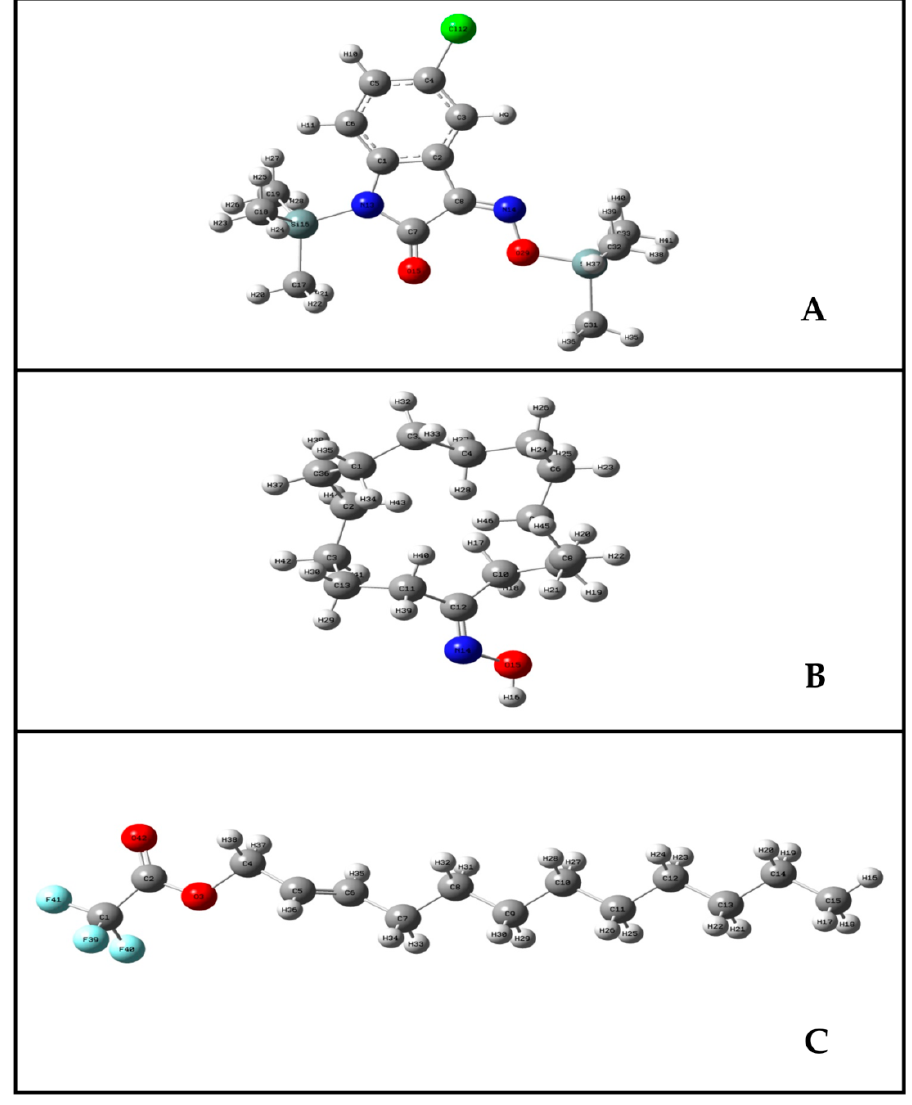
Figure 3. Optimized geometric structures of 5-chloro-1-(trimethylsilyl)-1H-indole-2,3-dione 3-[O-(trimethylsilyl)oxime] ( A ); cyclopentadecanone oxime ( B ) and trans -2-dodecen-1-ol trifluoroacetate ( C